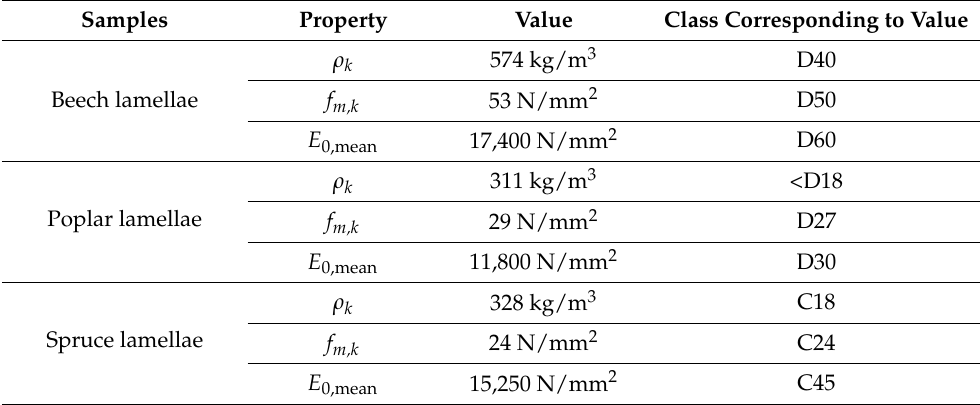
Table 9. Strength classes of the tested lamellae. Estimation of the strength classes according to EN 338 [18].